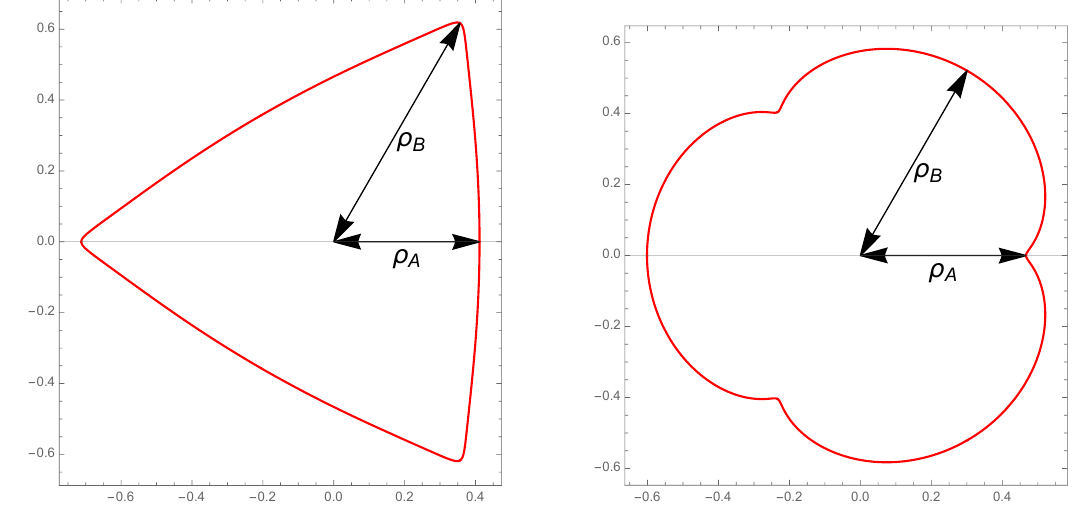
Figure 14 . Shapes of outward spike solutions and inward spike solutions: ρ A and ρ B are defined by ) and similarly for ρ . For outward spike solutions, we chose ( ω, ν, C, λ ) ’ r A = sin 2 ρ A ( 0 ≤ ρ A ≤ π B 2 (0 . 89 , 0 . 47 , 0 . 41 , 1 . 31) , which corresponds to ( ρ ) ’ (0 . 41 , 0 . 71) . For inward spike solutions, we A , ρ B chose ( ω, ν, C, λ ) ’ (1 . 65 , 0 . 51 , 0 . 94 , 2 . 57) , which corresponds to ( ρ ) ’ (0 . 47 , 0 . 60) . A , ρ B